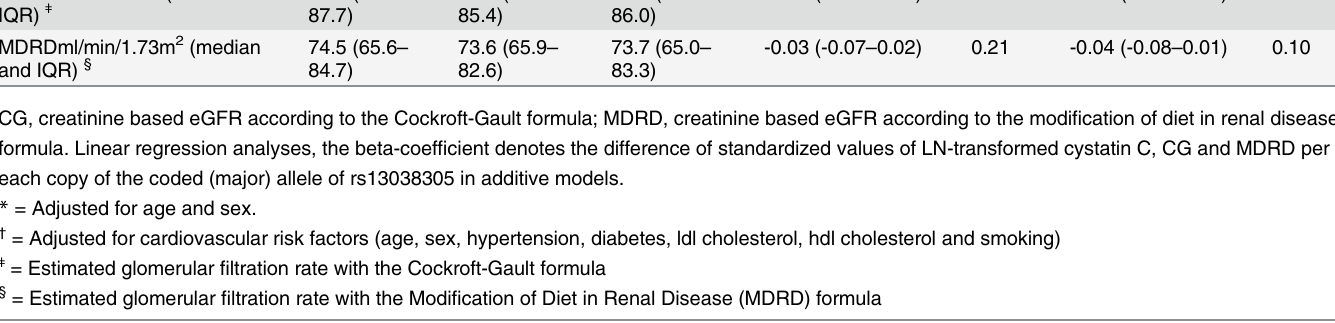
Table 2. The cystatin C locus rs13038305 SNP in relation to plasma concentration of cystatin C and eGFR (Cockroft-Gault and MDRD) in the MDC-CC cohort. TT (n = 223) CT (n = 1529) CC (n = 2991) B coef fi cient *